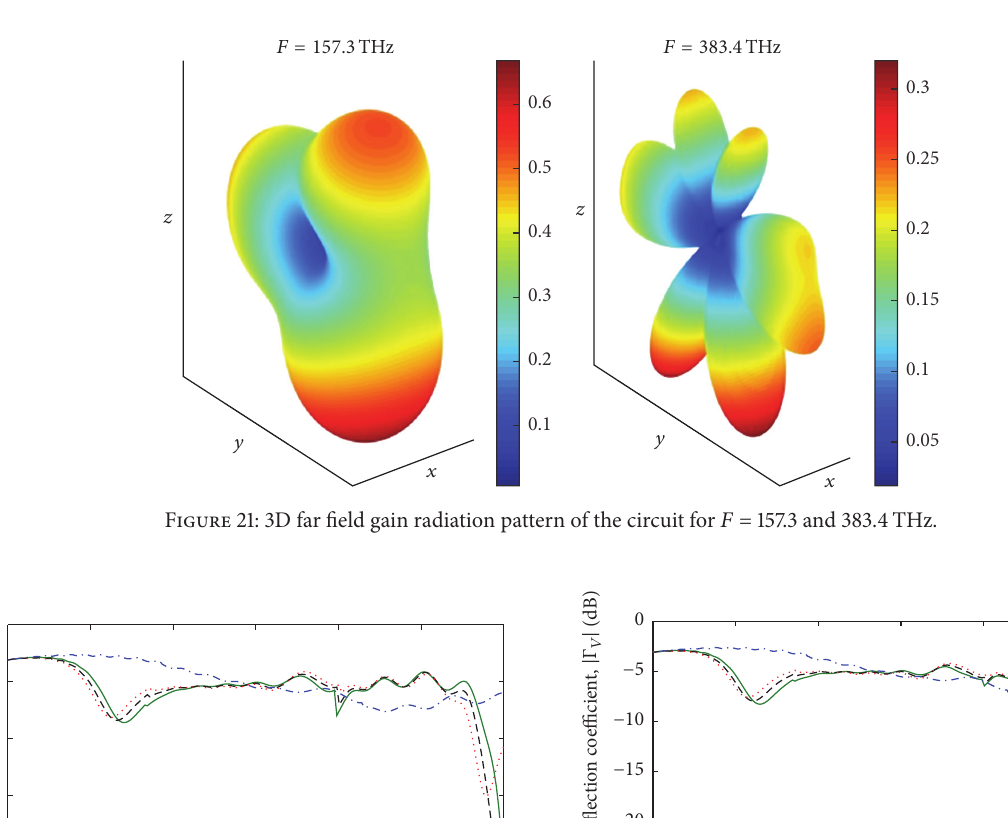
Figure 20: Electric field distribution in plane 𝑧 = 80 nm for the frequencies 𝐹 = 157.3 (a) and 383.4 (b)THz, for cases with the reflection coefficient |Γ 𝑉 | = − 7.6 and − 13.53 dB, respectively.